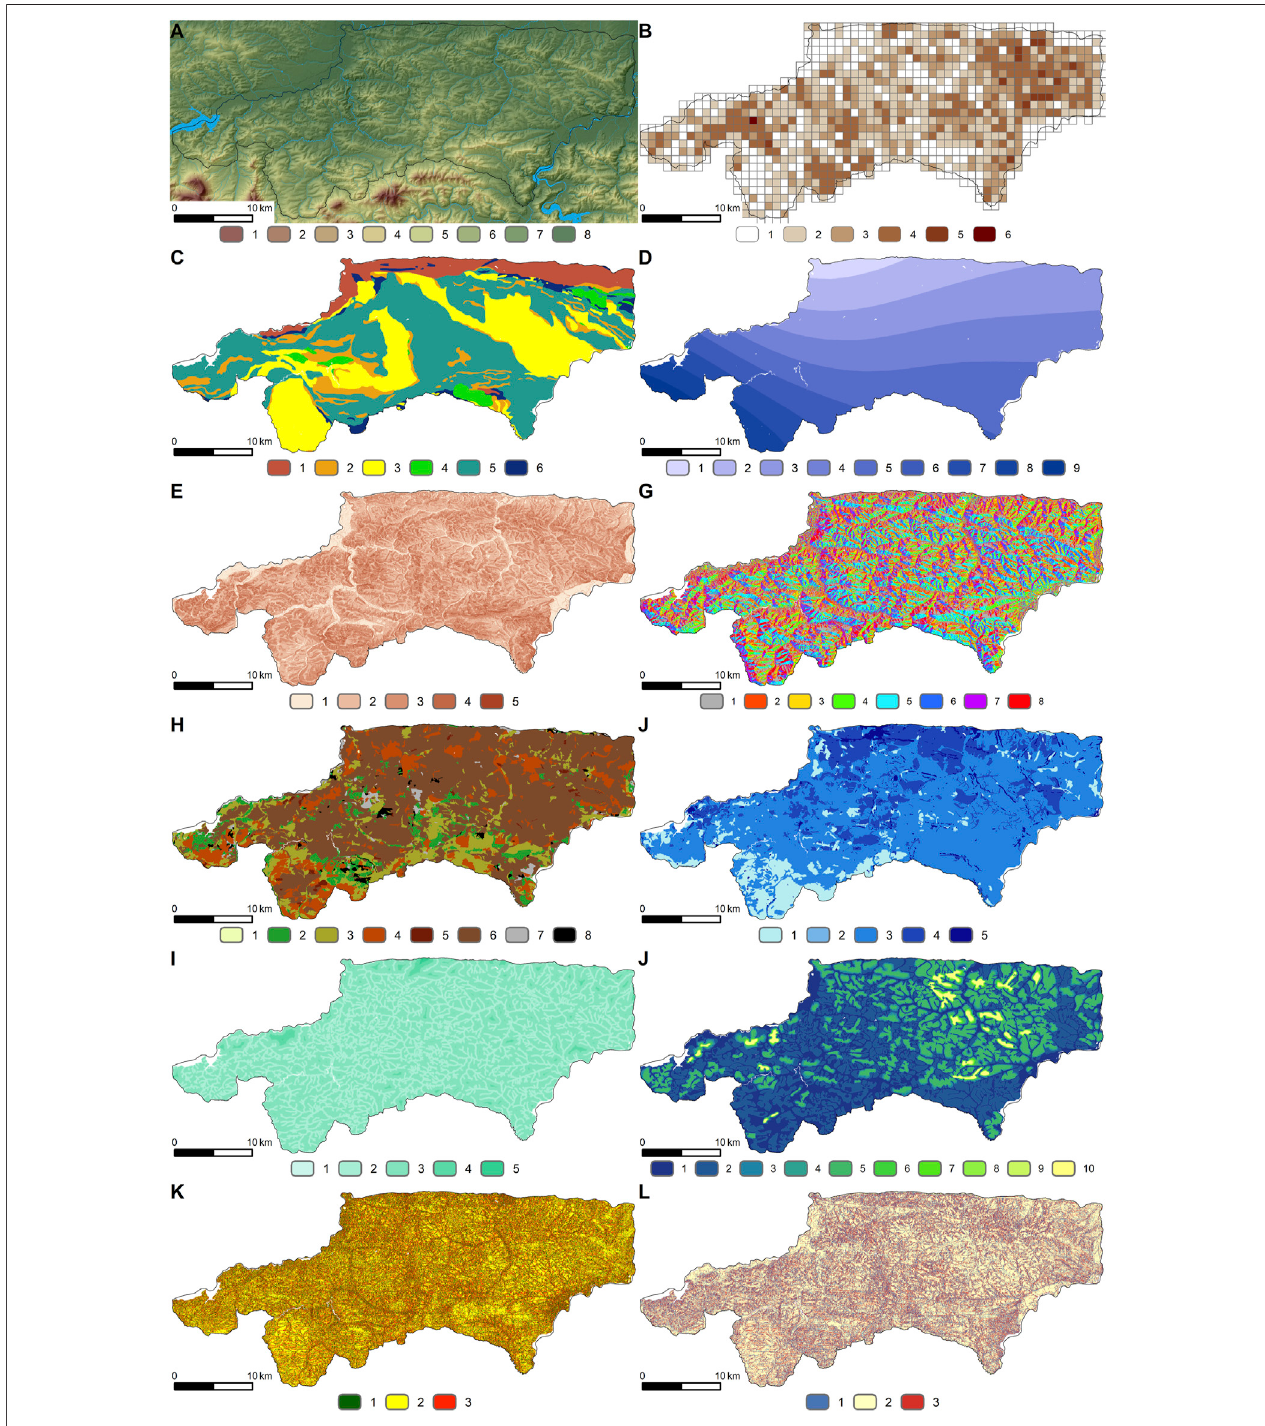
FIGURE2| Characteristicsoftheanalyzedarea (A,B) andsummaryofthematicmapsusedinlandslidesusceptibilityanalysis (C – L) : (A) Numericalterrainmodel[m below terrain] (1. 800 – 900; 2. 700 – 800; 3. 600 – 700; 4. 500 – 600; 5. 400 – 500; 6. 300 – 400; 7. 200 – 300; 8. 190 – 200). (B) Landslide density map (number of landslides/ 1 km 2 ) (1. 0; 2. 0 – 2; 3. 2 – 5; 4. 5 – 15; 5. 15 – 30; 6. 30 – 45). (C) Geological map (1. siltstone, claystone, sandy siltstone, sands and sandstone (Miocene); 2. variegated shale; 3. shale and sandstone; 4. sandstone; 5. sandstone and shale; 6. other (gypsum, anhydrite, rock salt, gaize, siliceous marl, gray marl). (D) Annual precipitation [mm](1. 675 – 700; 2.700 – 725;3. 725 – 750; 4.750 – 775;5. 775 – 800; 6.800 – 825;7. 825 – 850;8.850 – 875; 9.875 – 900). (E) Slopemap (degrees)(1. 0 – 2;